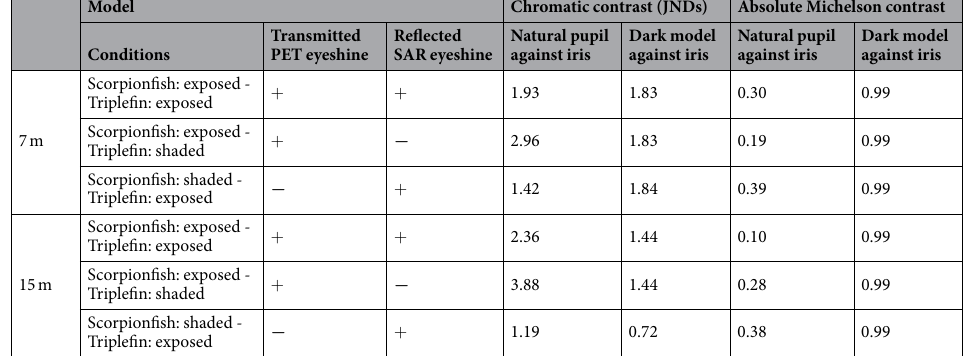
of reversed occlusion in the scorpionfish Scorpaena porcus and show that two different eyeshine types contribute to daytime pupil radiance: Stratum Argenteum Reflected (SAR) and Pigment Epithelium Transmitted (PET) eye- shine. Spectroradiometry in the field shows that daytime eyeshine reduces the contrast between pupil and iris,